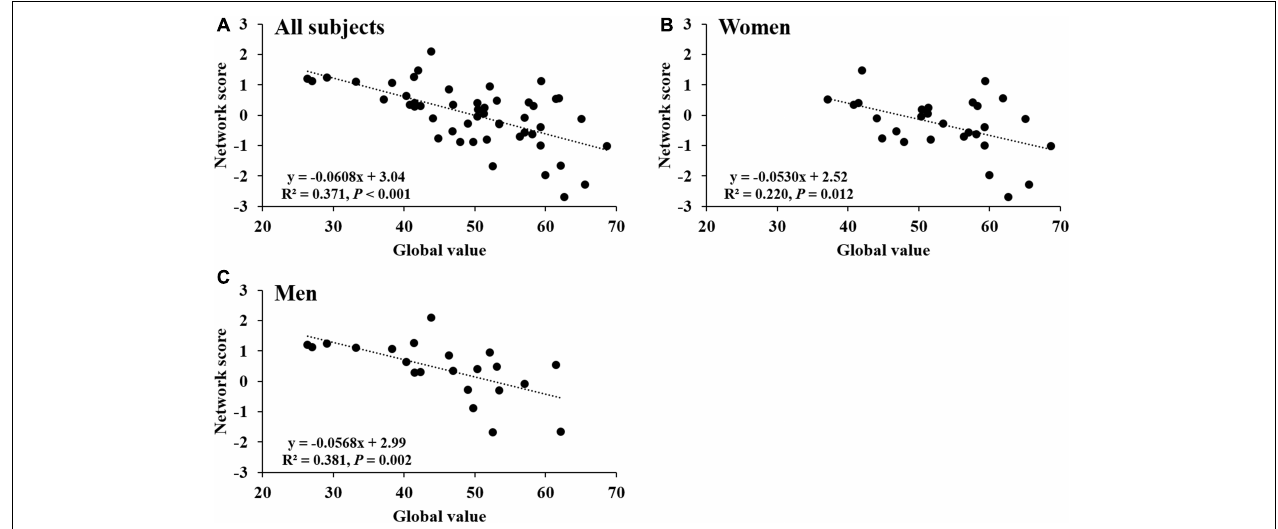
FIGURE 5 | Network score related to global value from CBF map. (A) This network score of combined PC1, PC5, and PC6 from PCA/SSM analysis correlated with the global value of CBF map in all healthy participants. (B) The network score correlated with the global value of CBF map in female subjects. (C) The network score correlated with the global value of CBF map in male